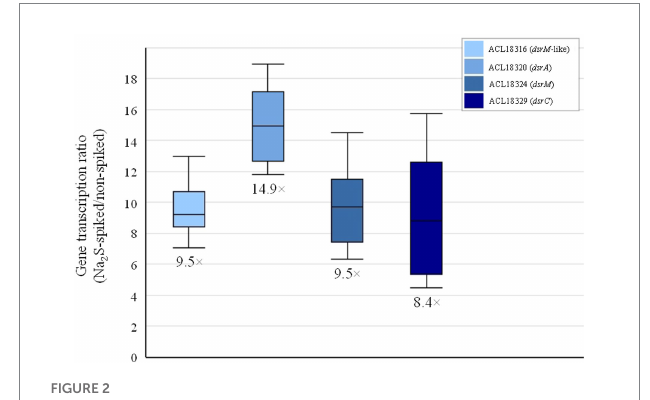
FIGURE 2 Induction of the transcription of selected dsr genes